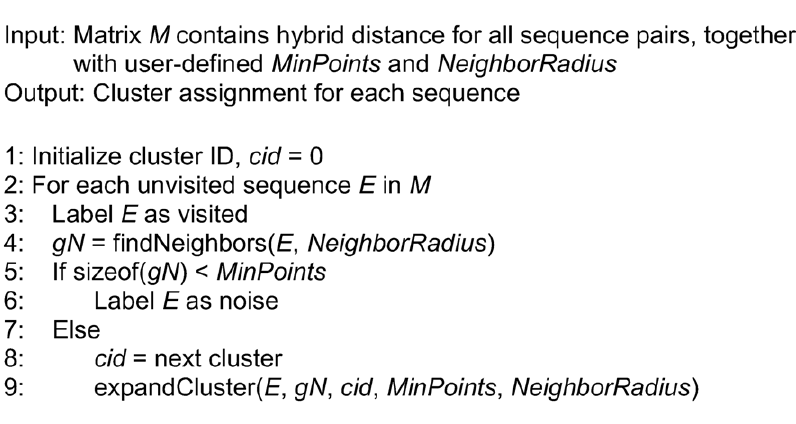
Figure 3. The pseudo codes for the DBSCAN function.